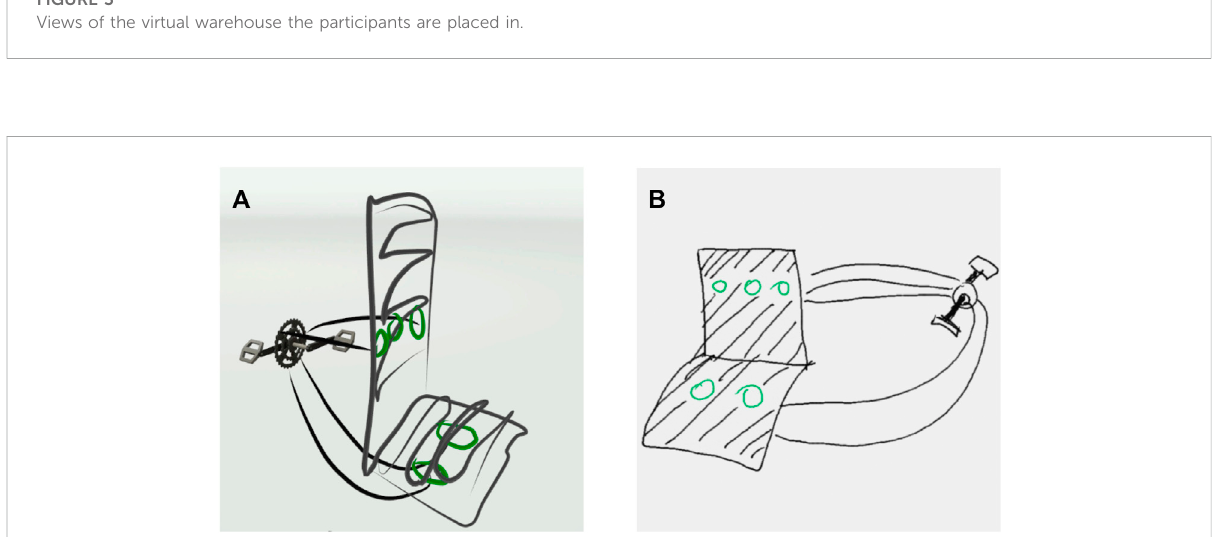
FIGURE 4 Massaging seat models presented to the participants: (A) in the virtual reality condition and (B) in the interactive whiteboard condition.